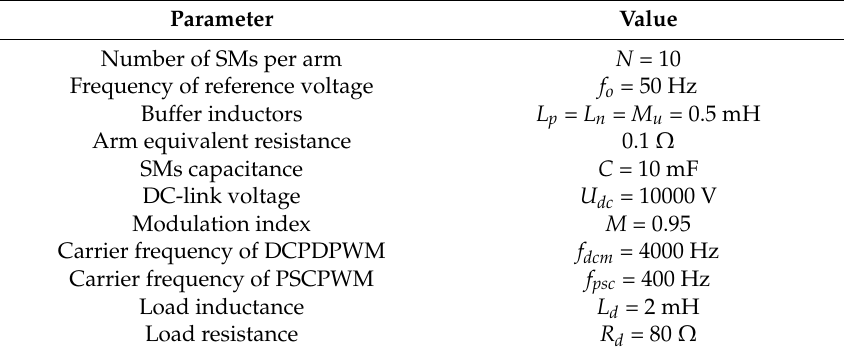
Table 1. Parameters of the